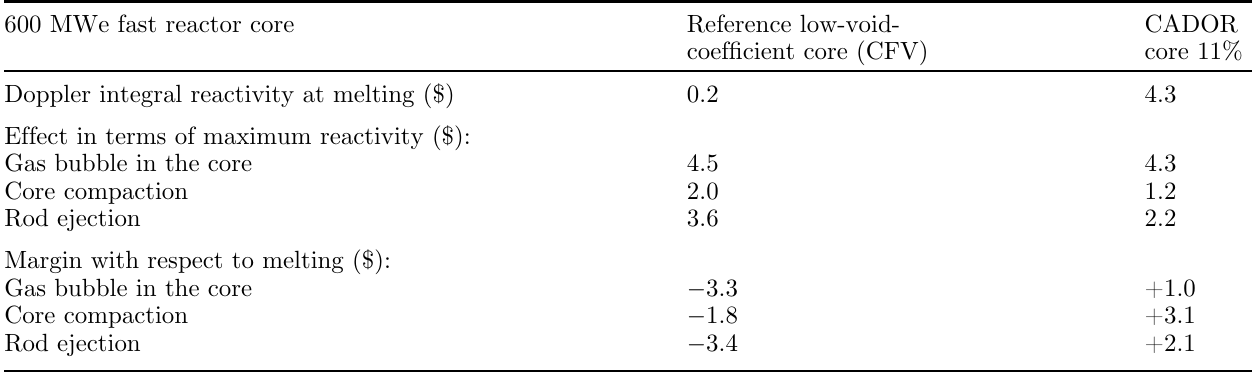
Table 2. Safety parameters of CADOR core compared to CFV